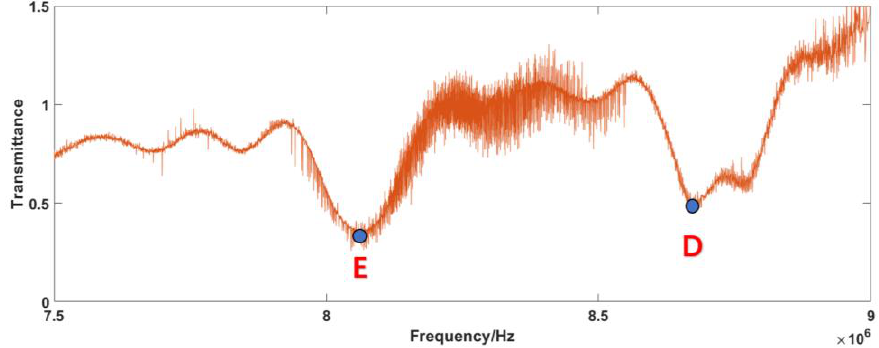
Figure 15. Normalized transmittance spectrum of the experiment signal.